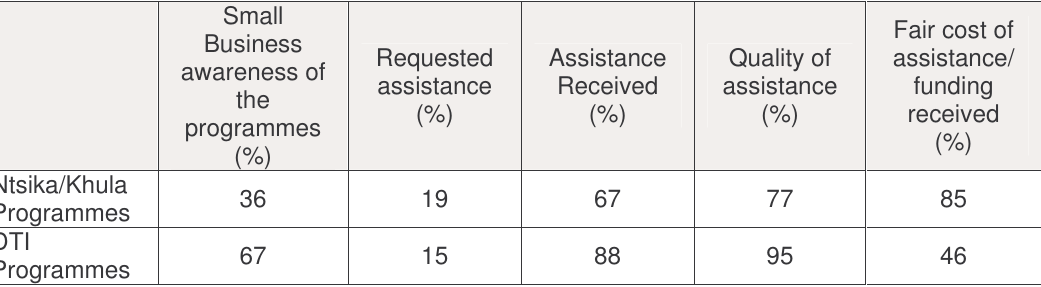
Table 1: Comparison of the use of Ntsika, Khula and DTI programmes in Greater Johannesburg-